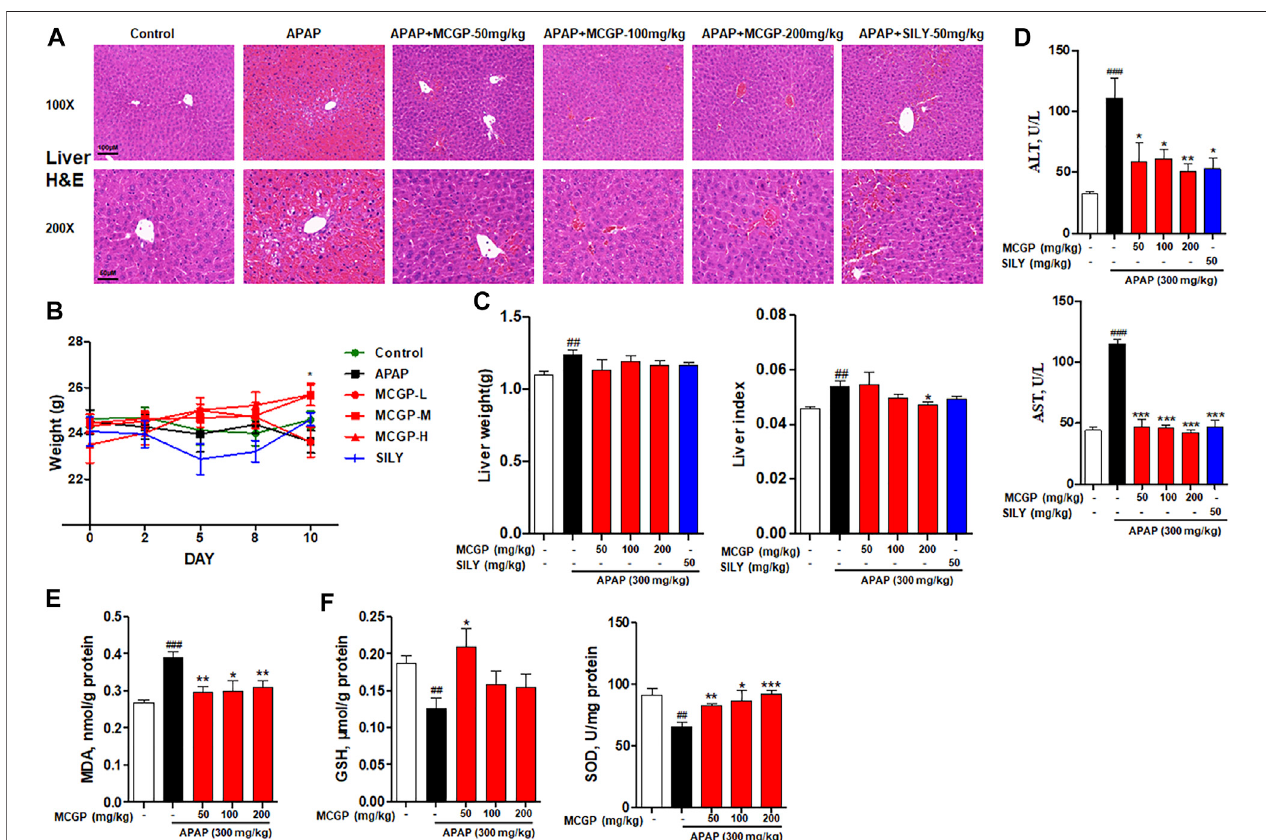
FIGURE 4 | MCGP treatment alleviated APAP-intoxicated liver injury. (A) Liver histological observation. Mice were pretreated with vehicle or various dosages of MCGP (50, 100 or 200 mg/kg) or positive control silymarin once a day for 10 days, and then followed with intragastric administration of APAP (300 mg/kg). Typical images are chosen from each experimental group: Control, APAP, MCGP-L + APAP, MCGP-M + APAP, MCGP-H + APAP, SILY (silymarin + APAP). (B) Mice weight of each group. (C) Liver weight and liver index of each group. (D) Serum ALT and AST activity. (E,F) Liver levels of GSH, MDA, and SOD in each group. Data were presented as the mean ± SEM. ## p < 0.01, ### p < 0.001 vs control, * p < 0.05, ** p < 0.01, *** p < 0.001 vs